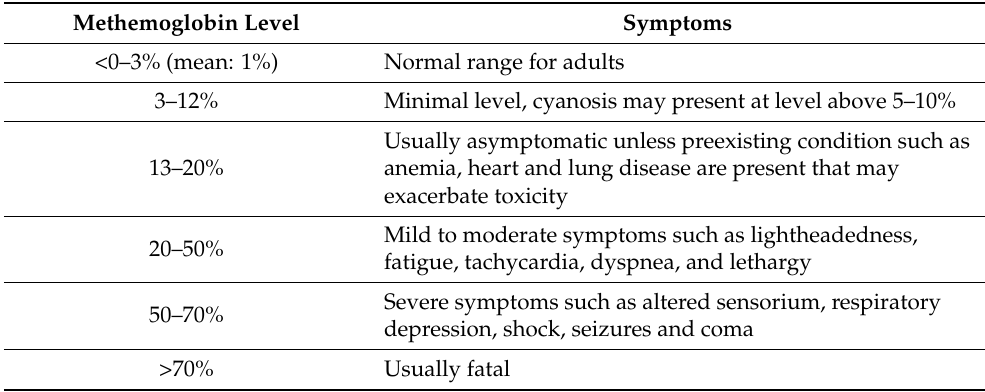
Table 2. Severity of symptoms of methemoglobinemia with methemoglobin level [7]. Methemoglobin